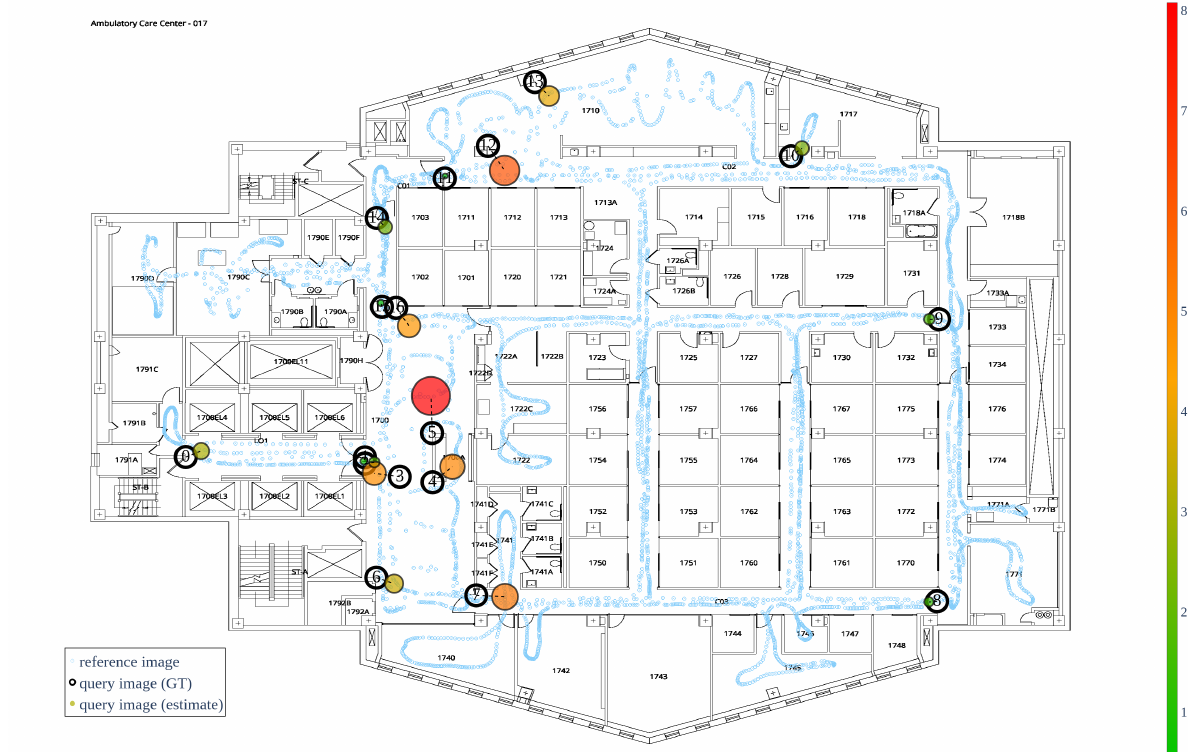
Figure 9. Location accuracy heatmap. The small open light-blue dots are the locations of n reference images on the floor plan. The open black circles are the ground truth locations of 17 testing images; the multi-colored circles next to the GT localizations colored from green to red are the estimated locations of these 17 testing images; the further from the ground truth location (ft), the larger the circle and the warmer the color